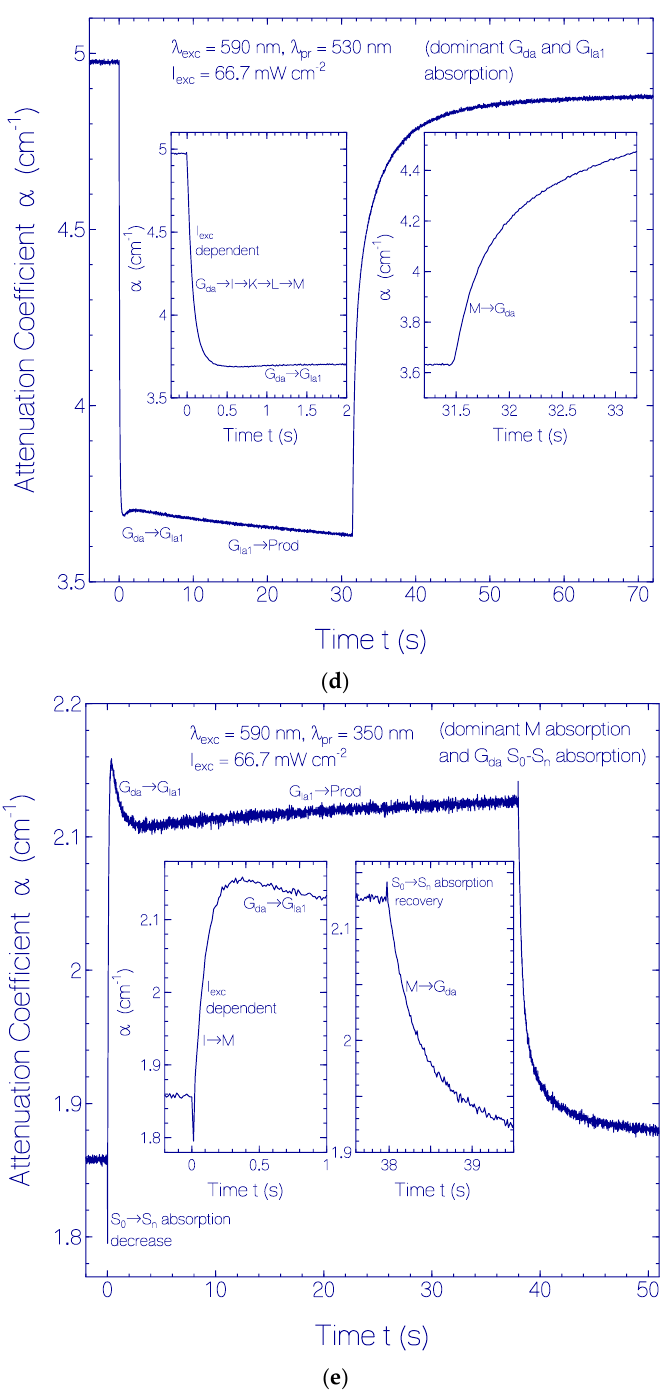
Figure 9. Temporal attenuation coefficient development of CaRh in pH 7.3 HEPES/MOPS buffer at ( a ) λ pr = 630 nm (approximate peak absorption position of PRSB 13 -cis K intermediate); ( b ) λ pr = 460 nm (approximate peak absorption position of PRSB 13 -cis ,cirp L intermediate); ( c ) λ pr = 370 nm (approximate peak absorption position of RSB 13 -cis M intermediate); ( d ) λ pr = 530 nm (dominant overlap of PRSB all -trans G da dark-adapted absorption band and G la1 light-adapted absorption band) and ( e ) λ pr = 350 nm (dominant overlap of RSB 13 -cis M absorption band and ground-state to higher excited-state G da dark-adapted absorption band).